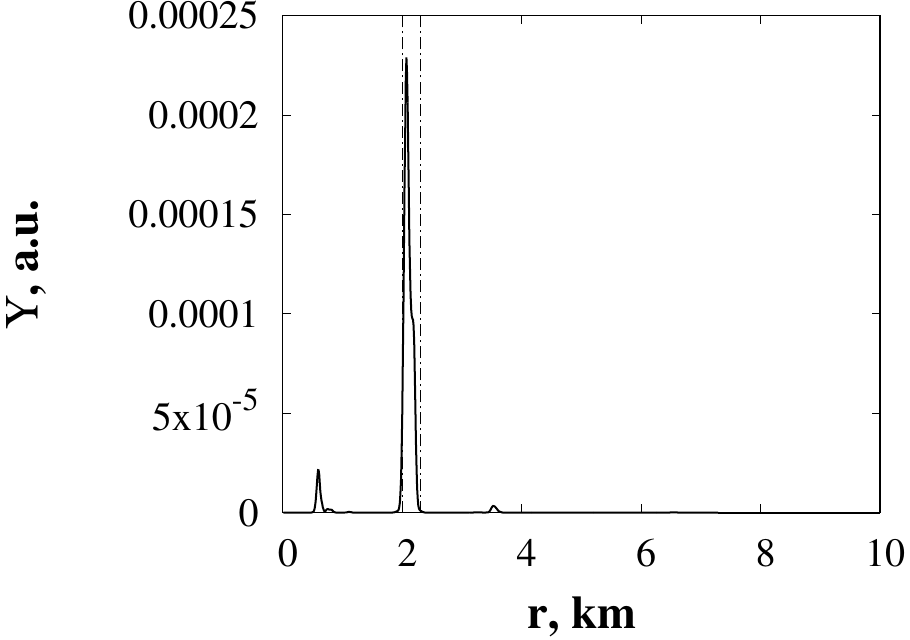
Figure 5. Solid line: overlap function Υ ( r ) for 14 beams corresponding to absorption spots for frequencies 100, 150, 200, 250, and 300 Hz. Vertical dot-dashed lines limit the pockmark